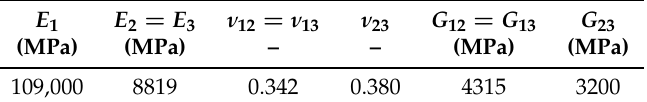
Table 1. Lamina elastic moduli.